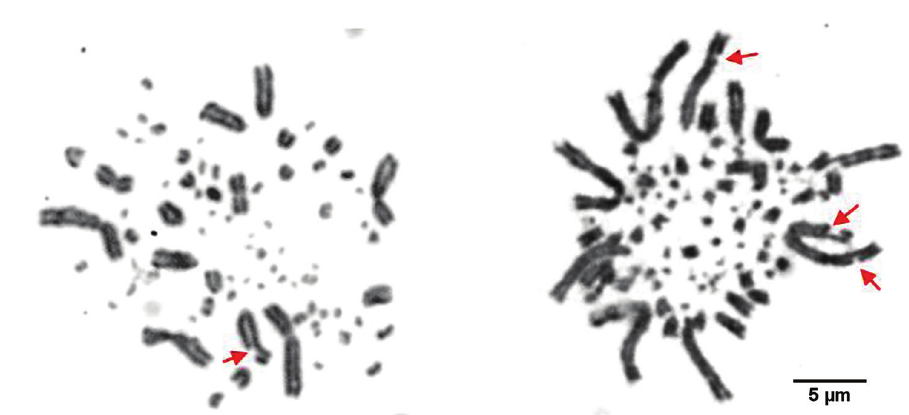
Figure 3. Partridges’ metaphases showing spatial distribution of chromosomes ( A. barbara on the left and A. chukar on the right). Macrochromosomes are located towards metaphases periphery, microchro- mosomes are confined to the central area. Arrows indicates break points in chromosomes. Bar = 5